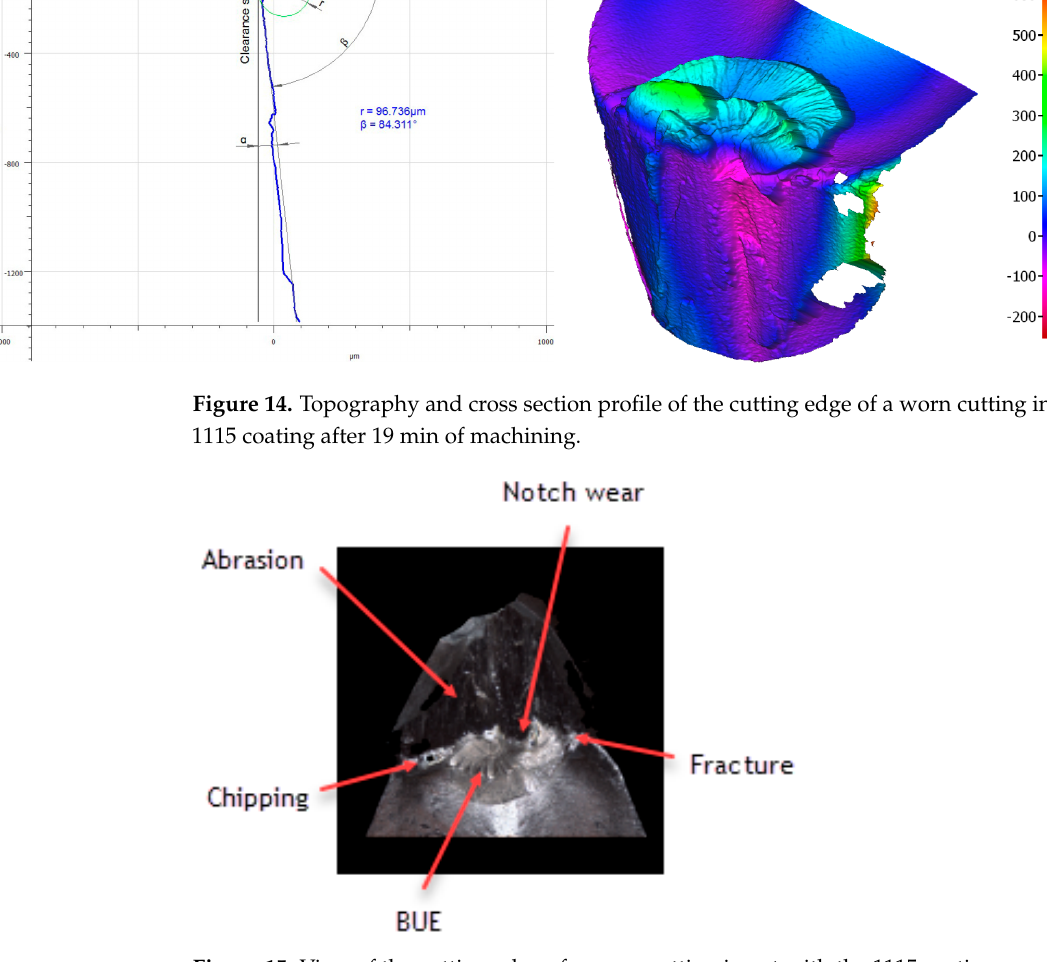
Figure 15. View of the cutting edge of a worn cutting insert with the 1115 coating.